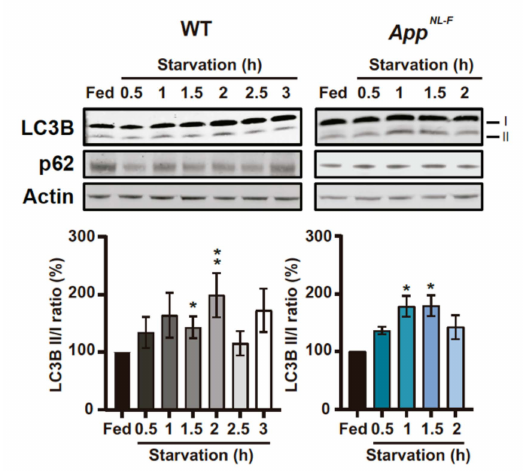
Figure 3. Levels of microtubules-associated protein 1A / 1B-light chain 3B (LC3) and SQSTM1 / p62 (p62) are altered in WT and App NL-F PCNduring starvation. Representative immunoblots of LC3B and p62 in starved 14 days in vitro (DIV) PCN derived from WT and App NL-F and respective quantification of LC3B II / I ratio (WT: p = 0.0272 Fed vs. 1.5 and p = 0.0013 (3 ≤ n ≤ 10); App NL-F p = 0.0286 Fed vs. 1 and Fed vs. 1.5 ( n = 4)). P -values were obtained by using non-parametric independent Mann–Whitney U test (comparison to Fed). * p ≤ 0.05 and ** p ≤ 0.01 were considered